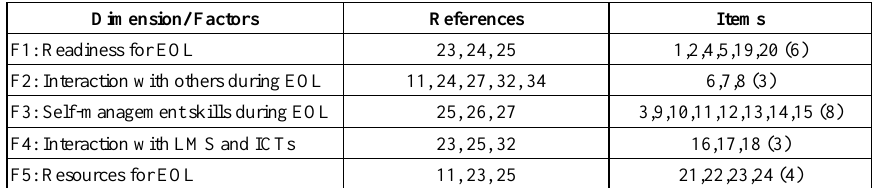
Table 1. Structure for the construction of instrument dimensions and items Dimension/